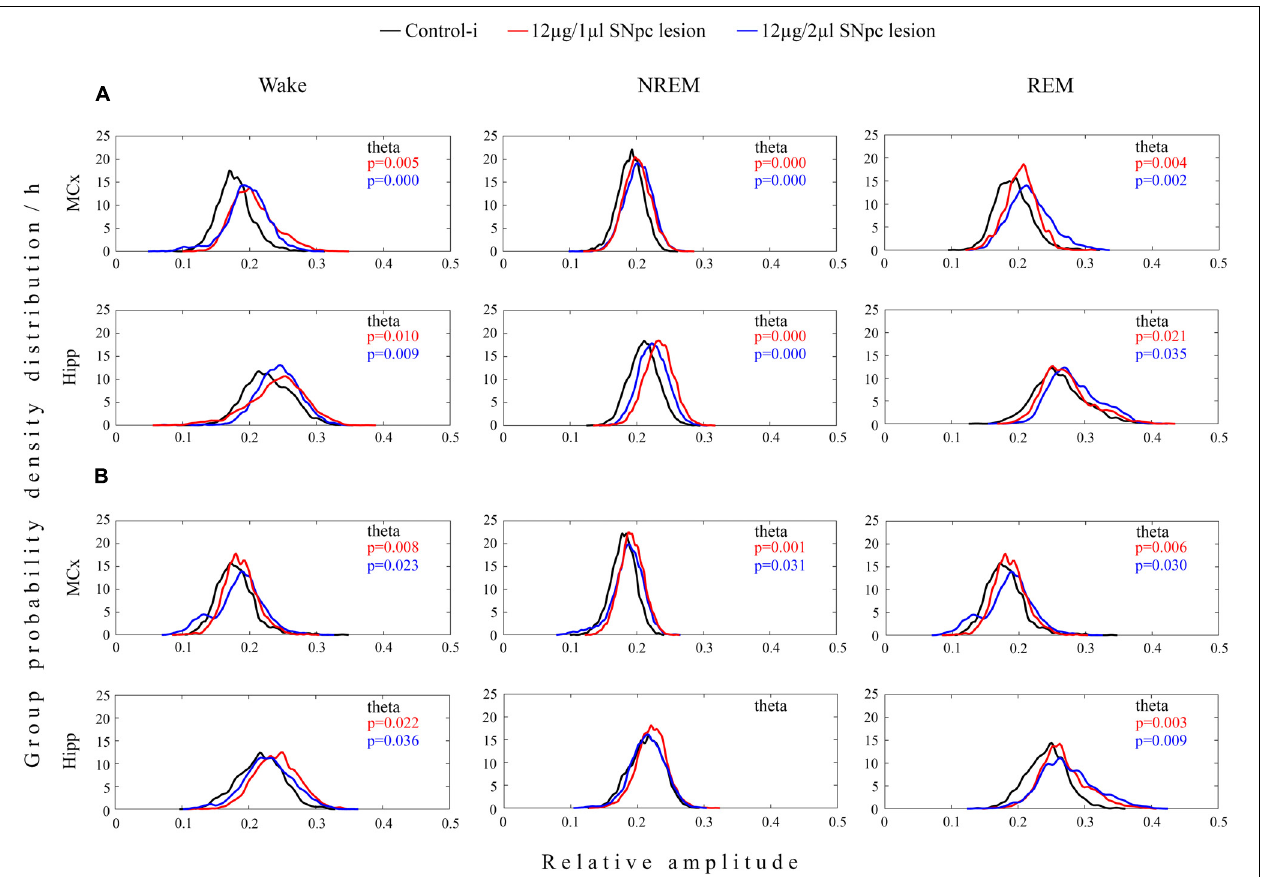
FIGURE 3 | Unilateral dopaminergic neuronal loss in the SNpc augmented theta amplitude across Wake, NREM and REM sleep in the MCx and hippocampus (Hipp) 14 (A) and 42 (B) days following the SNpc lesion caused by a microinfusion of 12 µ g/1 µ l 6-OHDA (12 µ g/1 µ l SNpc lesion) and 12 µ g/2 µ l 6-OHDA (12 µ g/2 µ l SNpc lesion). Theta amplitude augmentation following the unilateral SNpc lesion was particularly long-lasting in the MCx and Hipp during both Wake and REM